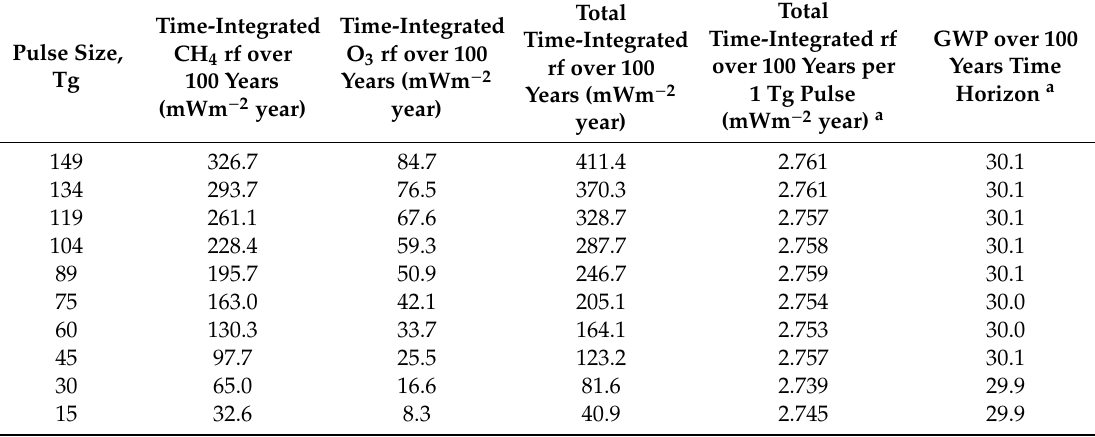
Table 2. Time-integrated radiative forcing (rf) over a 100-year time horizon for di ff erent-sized CH 4 emission pulses, together with the estimated global warming potential (GWP) with the ‘Best Estimate’ model